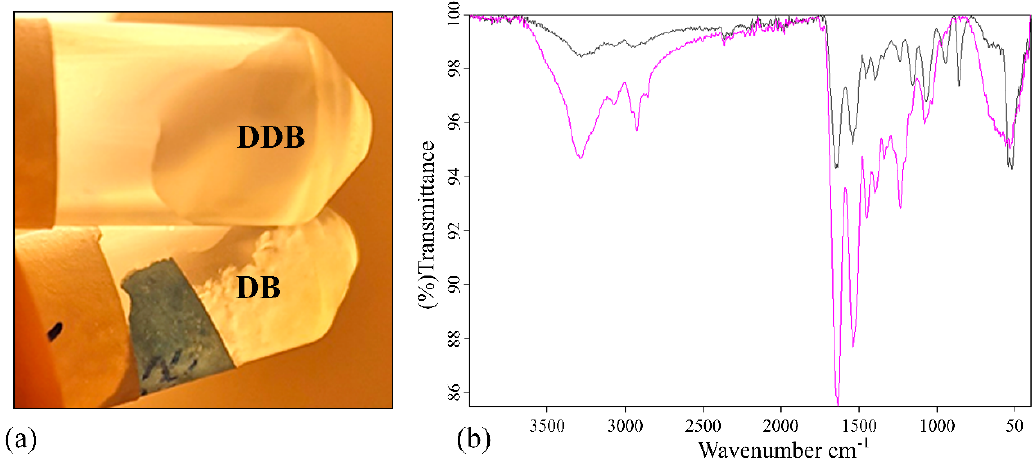
Figure 1. Pepsin digestion analysis. ( a ) Photograph of the samples in phosphate buffered saline stirred overnight at room temperature: (top) enzymatically digested decellularized bladder (DDB); (bottom) decellularized bladder (DB). ( b ) Fourier-transform infrared spectroscopy spectra of DB powder in black and DDB powder in pink in the region of 4000–400 cm − 1 .